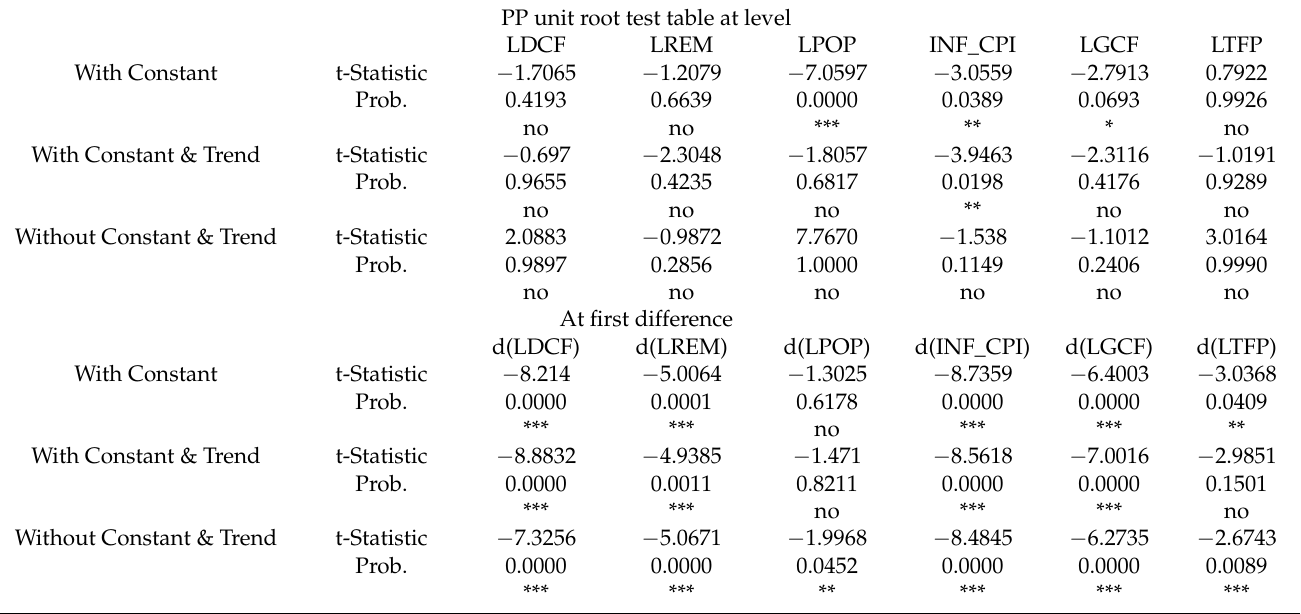
Table A2. Unit root ADF test at level and first